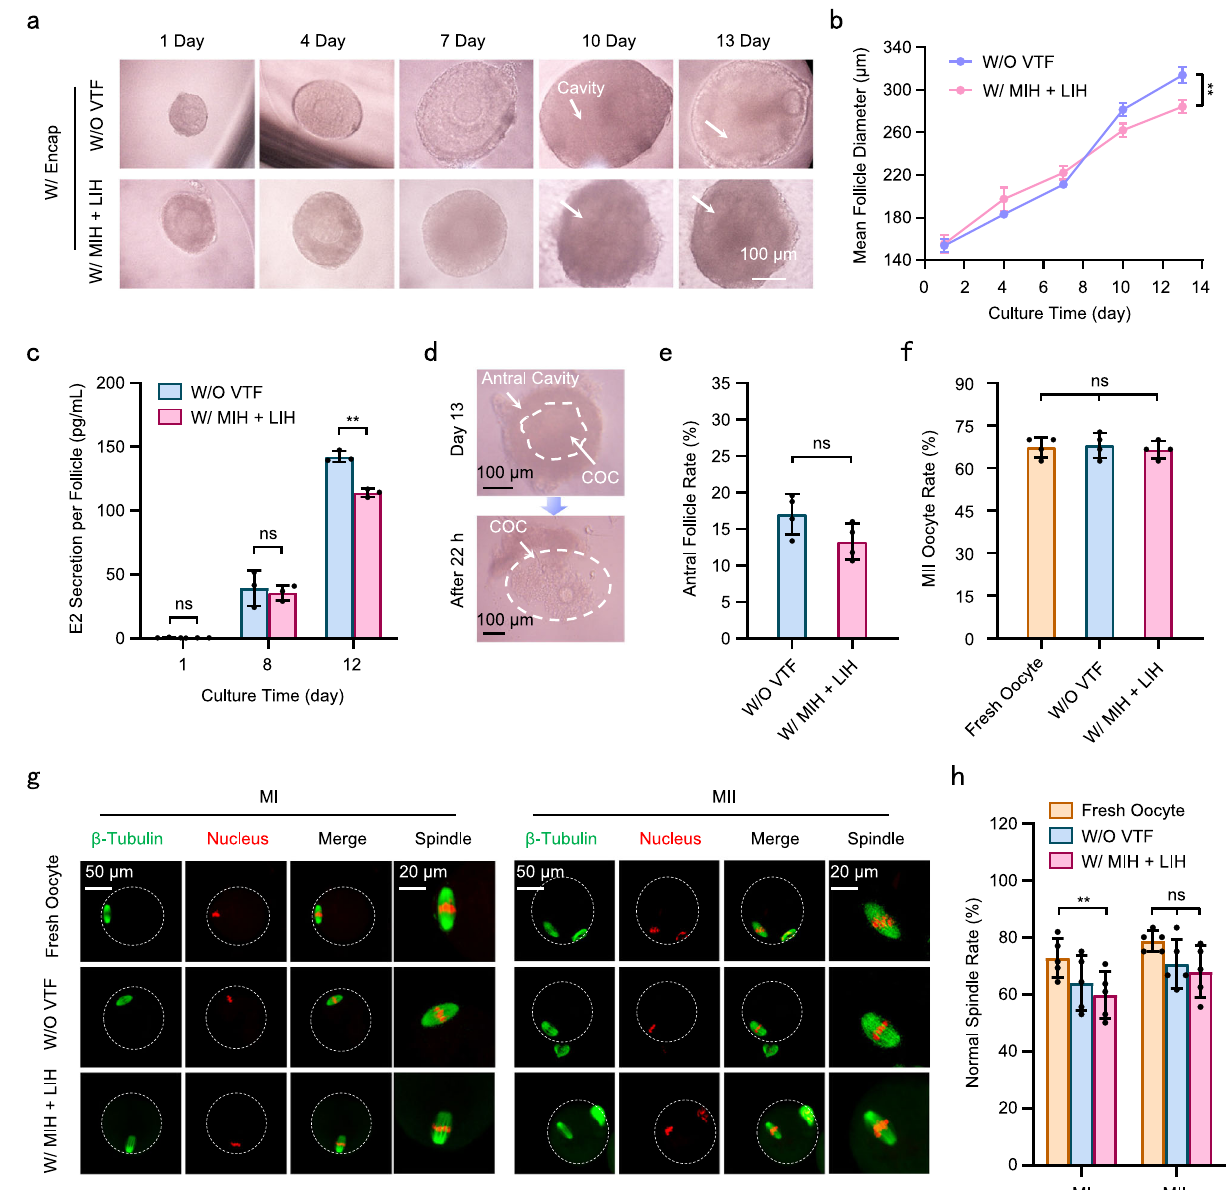
Fig. 4 | The effect of cryopreservation on the development capacity of PAFs. a Typical developmental images of PAFs after vitri fi cation (VTF). b Growth of PAFs warmed with MIH and LIH. Day 13: P W/O VTF-W/ MIH+LIH =0.0011. c Secretion of estradiol (E2) from growing PAFs. Day 12: P W/O VTF-W/ MIH+LIH =0.0020. d The pic- tures of COCs collection. e The percentage of PAFs developing to antral follicles. f Percentage of MII oocytes in the collected COCs. g Confocal images of spindle morphology in oocytes. h Normal ratio of spindles in oocytes. MI: P Fresh oocyte-W/ MIH+LIH =0.0385. W/O VTF: PAFs were only encapsulated in hydrogel and did not undergo vitri fi cation; W/ MIH+LIH: PAFs encapsulated in hydrogel were warmed with MIH and LIH after vitri fi cation. Fresh oocytes: MII oocytes obtained directly